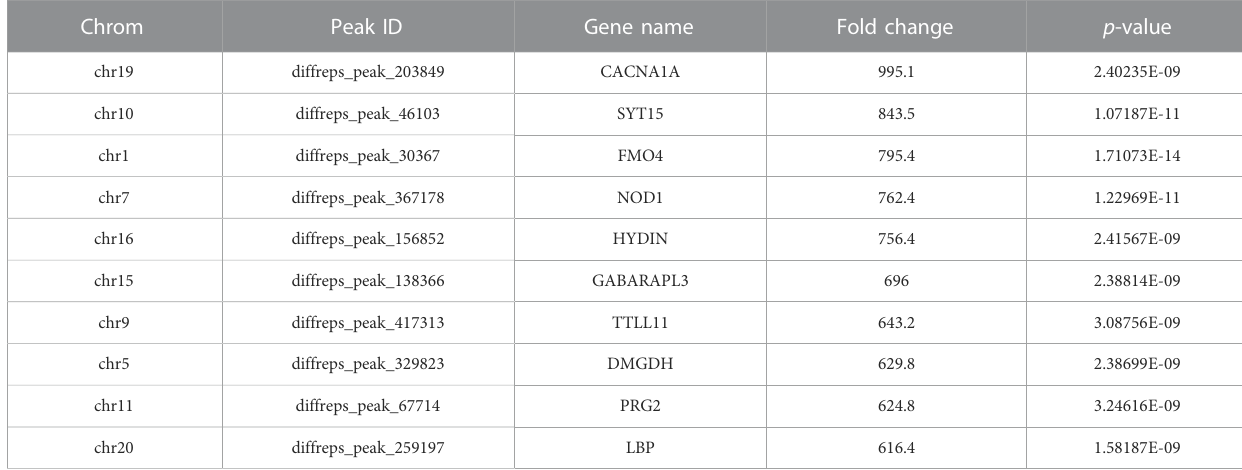
TABLE 1 Top Ten Upregulated m5C Methylation